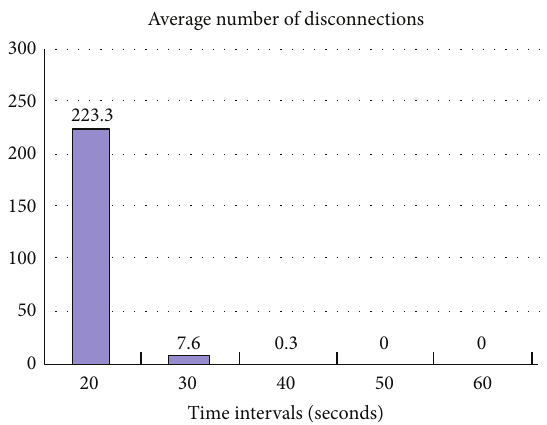
Figure 10: Average number of disconnections with varied time